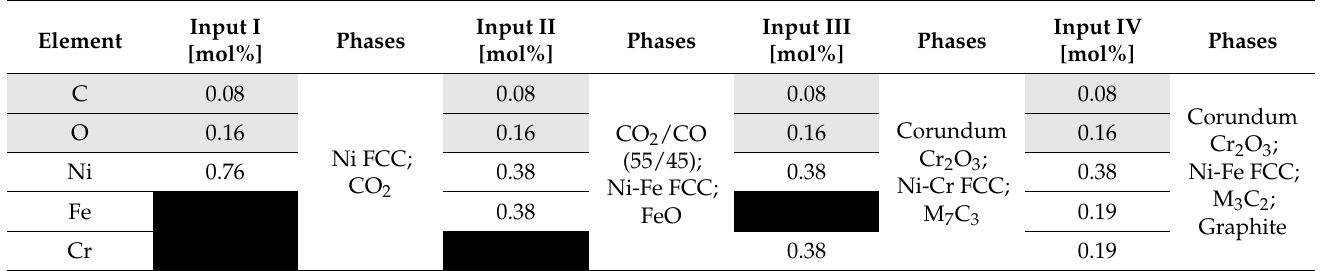
Table 3. Single point equilibrium calculation for C = 8 mol%, O = 16 mol% and Ni + Fe + Cr = 76 mol% in four input sets, T = 800 ◦ C, p = 1 bar and the corresponding output phases at equilibrium calculated by using the Thermocalc 2020b software package, TCNI 10.0 database in the (Thermo-Calc Software AB: Stockholm, Sweden, 2020)